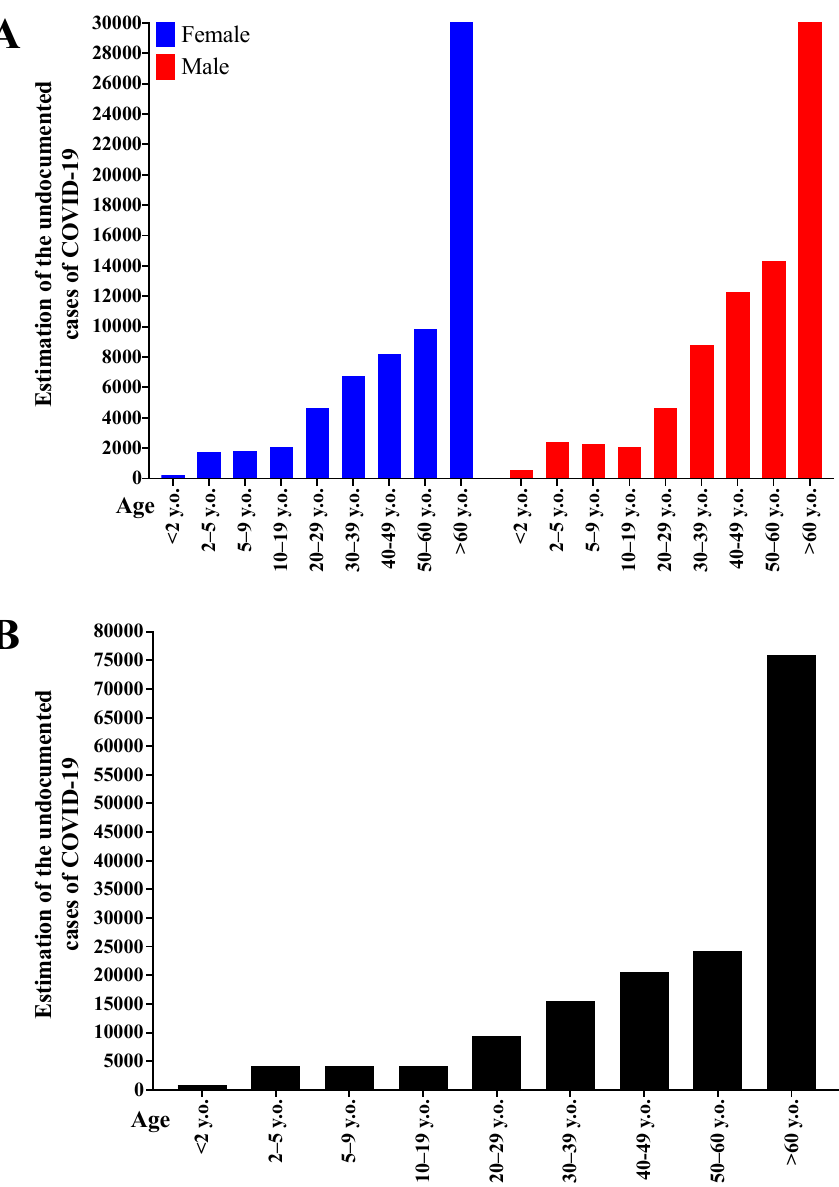
Figure 4. Number of cases in absolute value of possible Coronavirus Disease (COVID-19) underdiagnosis according to sex (female and male) and age groups (years old, y.o.: <2; 2–4; 5–9; 10–19; 20–29; 30–39; 40–49; 50–59; and +60) ( A ) and according to age only ( B ). The analysis included only data from 2020.